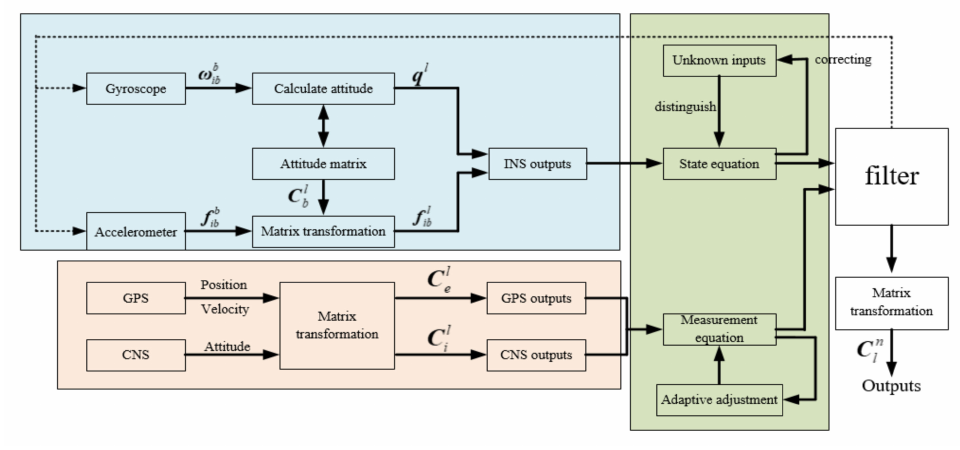
Figure 1. INS/CNS/GPS integrated navigation algorithm structure diagram in launch inertial coordinate